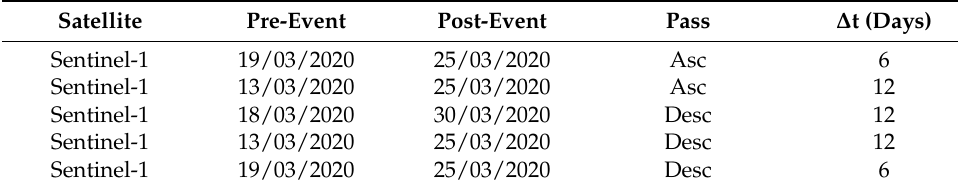
Table 1. Radar satellite data used.